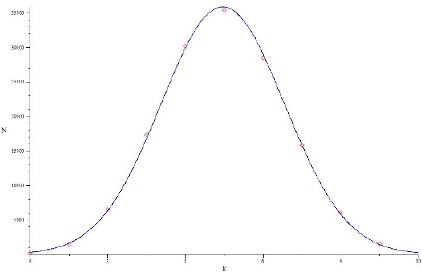
Figure 2 . Red dots are N numbers, blue curve is a Gaussian distribution with parameters [3 ; 1] ; (cid:0) 16 ;k (cid:22) = 11 : 7 ; (cid:27) = 2 : 42 ; I = 1 : 51 (cid:1) 10 13 .